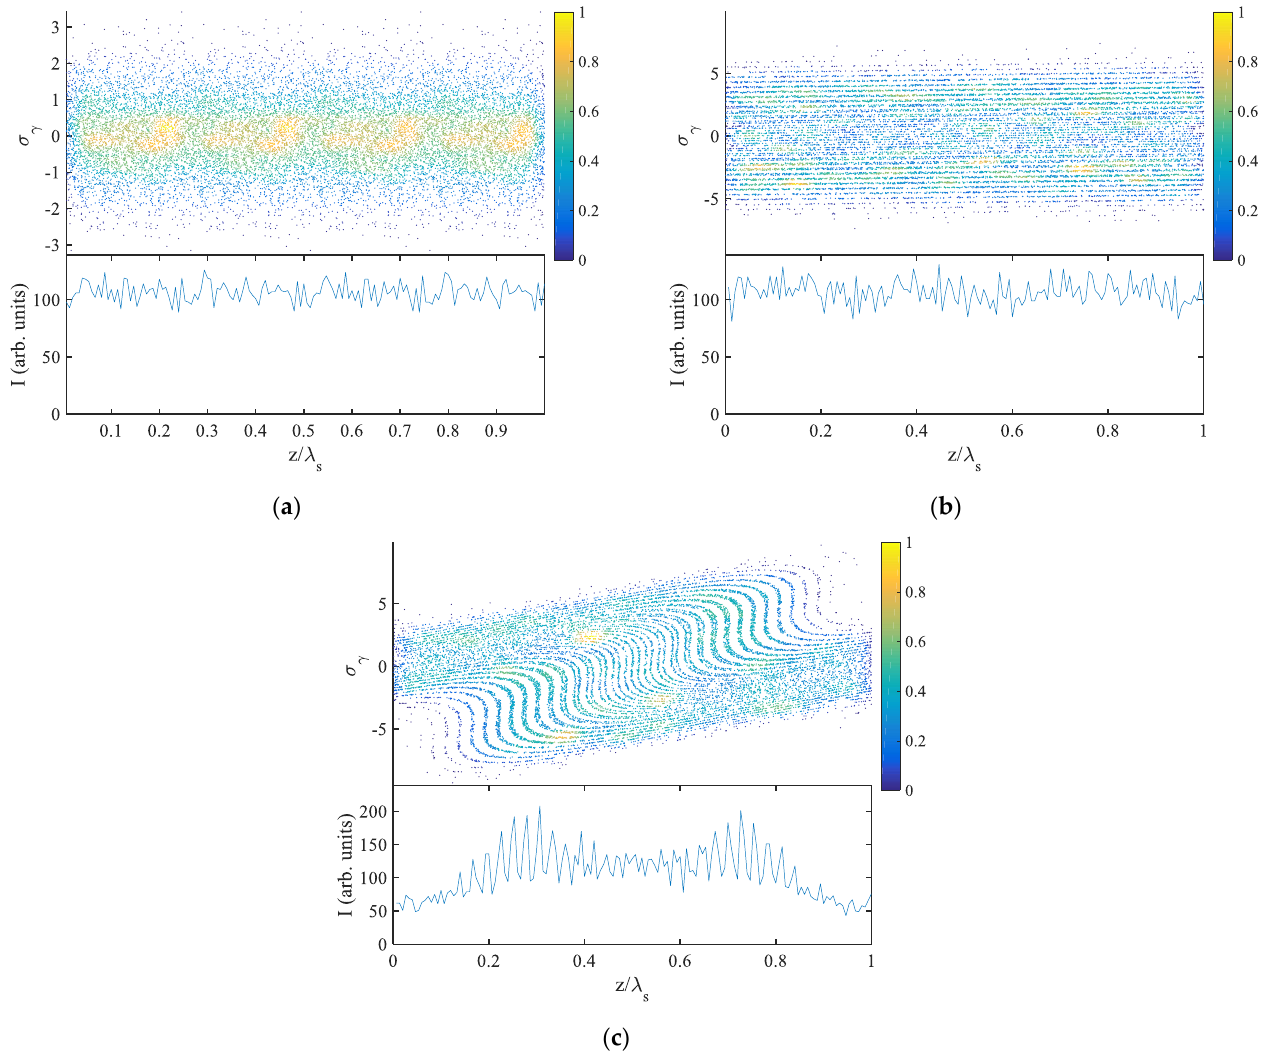
Figure 3. The longitudinal phase space and current profile evolutions in EEHG technique. ( a ) Phase space and current before the modulator 1; ( b ) Phase space and current at the exit of dispersion 1; ( c ) Phase space and current at the exit of dispersion 2.